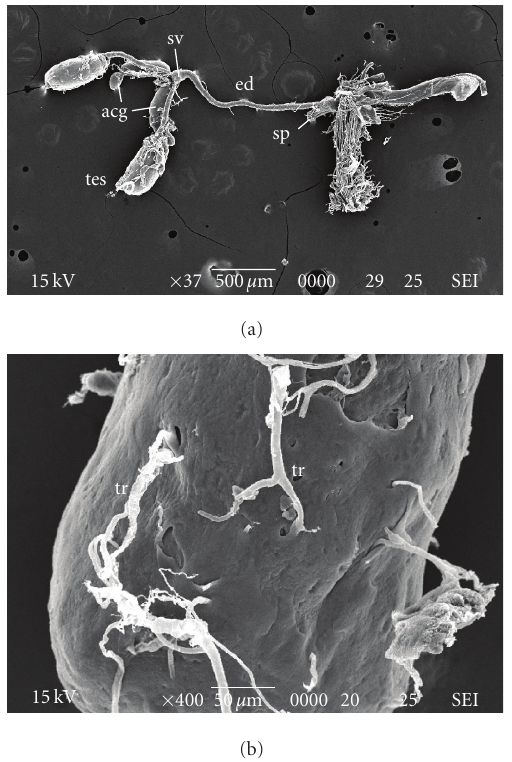
Figure 2: SEM image of internal reproductive tract in male C. megacephala . (a) Whole tract showing testes (tes), vas deferens (vd), seminal vesicle (sv), accessory gland (acg), ejaculatory duct (ed), and sperm pump (sp). (b) Testis showing the smooth surface and is occasionally penetrated by tracheoles (tr).